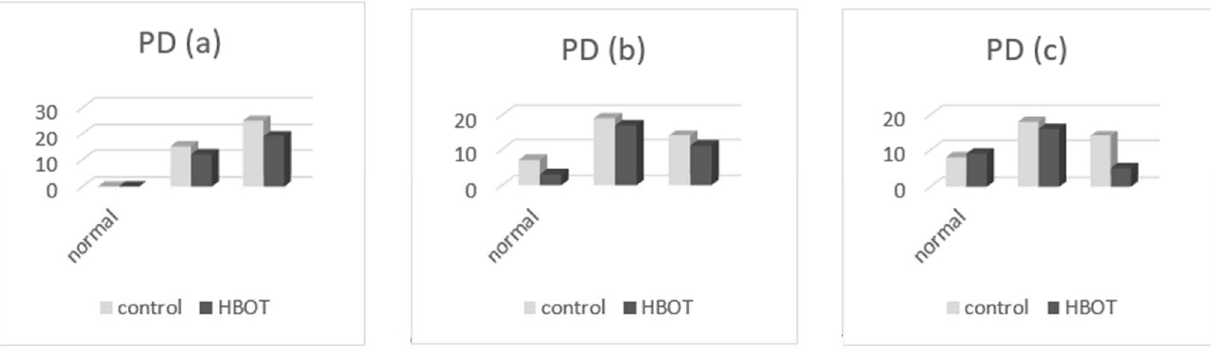
Figure 6. Patient distribution based on DM index at ( a ) first examination, ( b ) second examination, and ( c ) third examination.